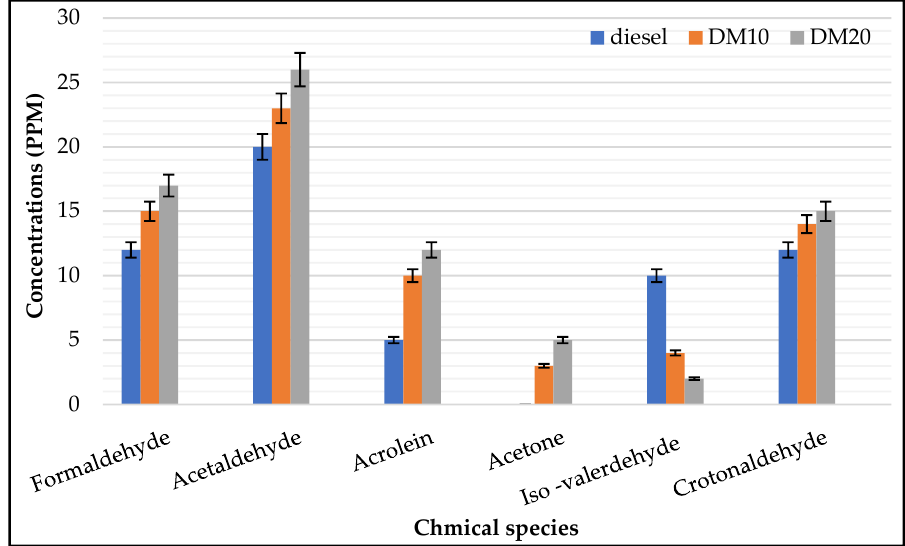
Figure 5. Emissions concentration with carbonyl compounds speciation (2 bar NMEP).